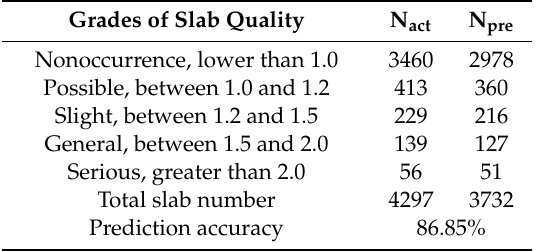
Table 8. Comparison of the actual collected results with the model prediction